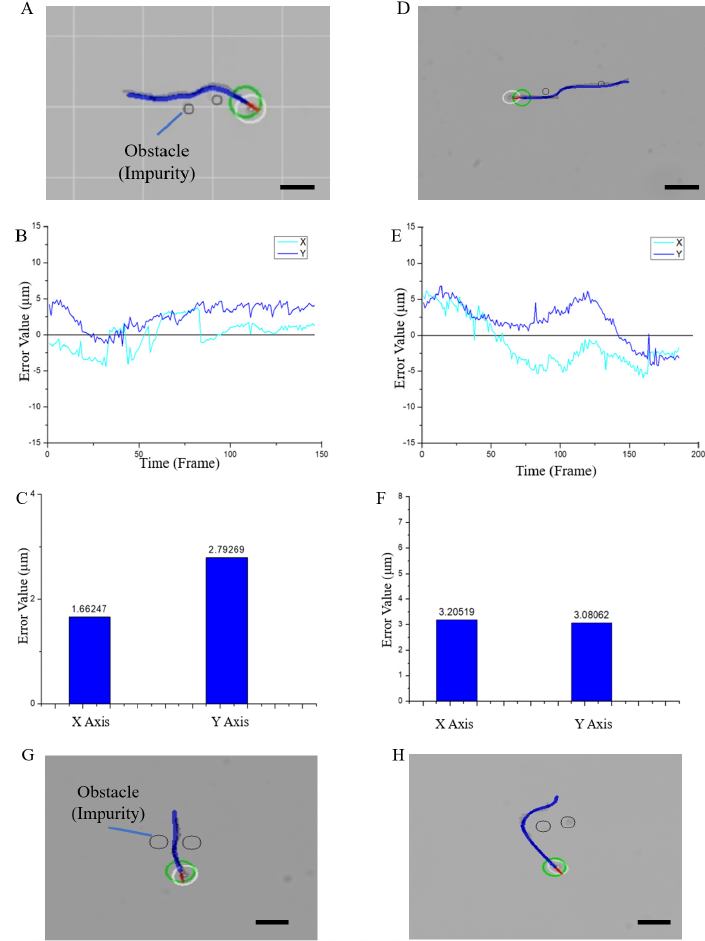
Figure 8. Experimental results of obstacle avoidance and trajectory planning in two situations. ( A – C ) Multiple adjacent obstacles in the motion space. ( A ) Superposition diagram of the simulated path and actual moving path. ( B ) Error variation trend. ( C ) The average value of the absolute error in the X and Y directions. ( D – F ) Multiple obstacles at large distances in the motion space. ( D ) Superposi- tion diagram of the simulated path and actual moving path. ( E ) Error variation trend. ( F ) The aver- age value of the absolute error in the X and Y directions. ( G , H ) Intelligent path planning motion control in the field with obstacles at different spacings. The motion trajectory drawn by the motion simulation system and the actual motion trajectory of the magnetic microrobot is superimposed. Scale bars are 30 μ m.